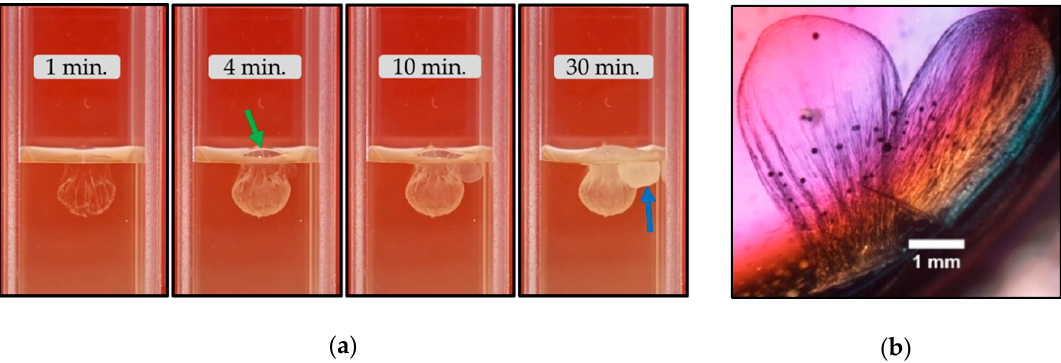
Figure 13. ( a ) The growth process of magnesium chloride mineral vesicles in Magadi water (note: two vesicles grow from one drop; the width of the cuvette is 1.25 cm); ( b ) lateral view of magnesium sulphate vesicle.